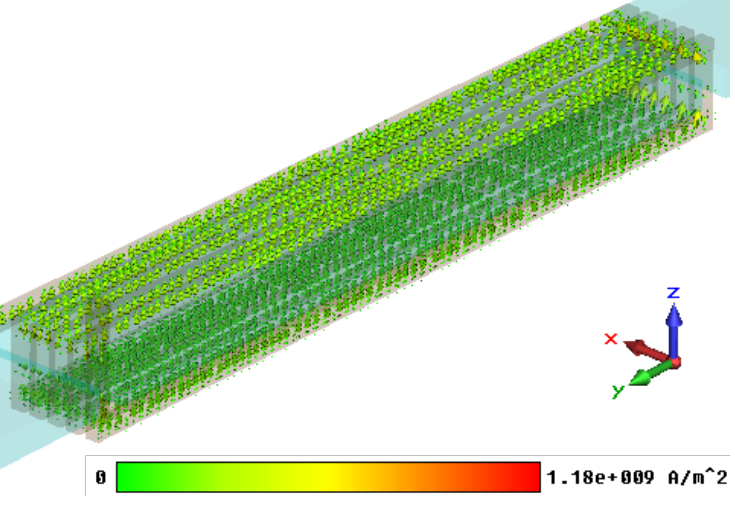
Figure 17. Steady current field of the partial sensor